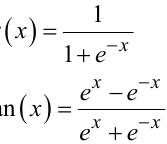
Figure 8. Description of the training parameters and input